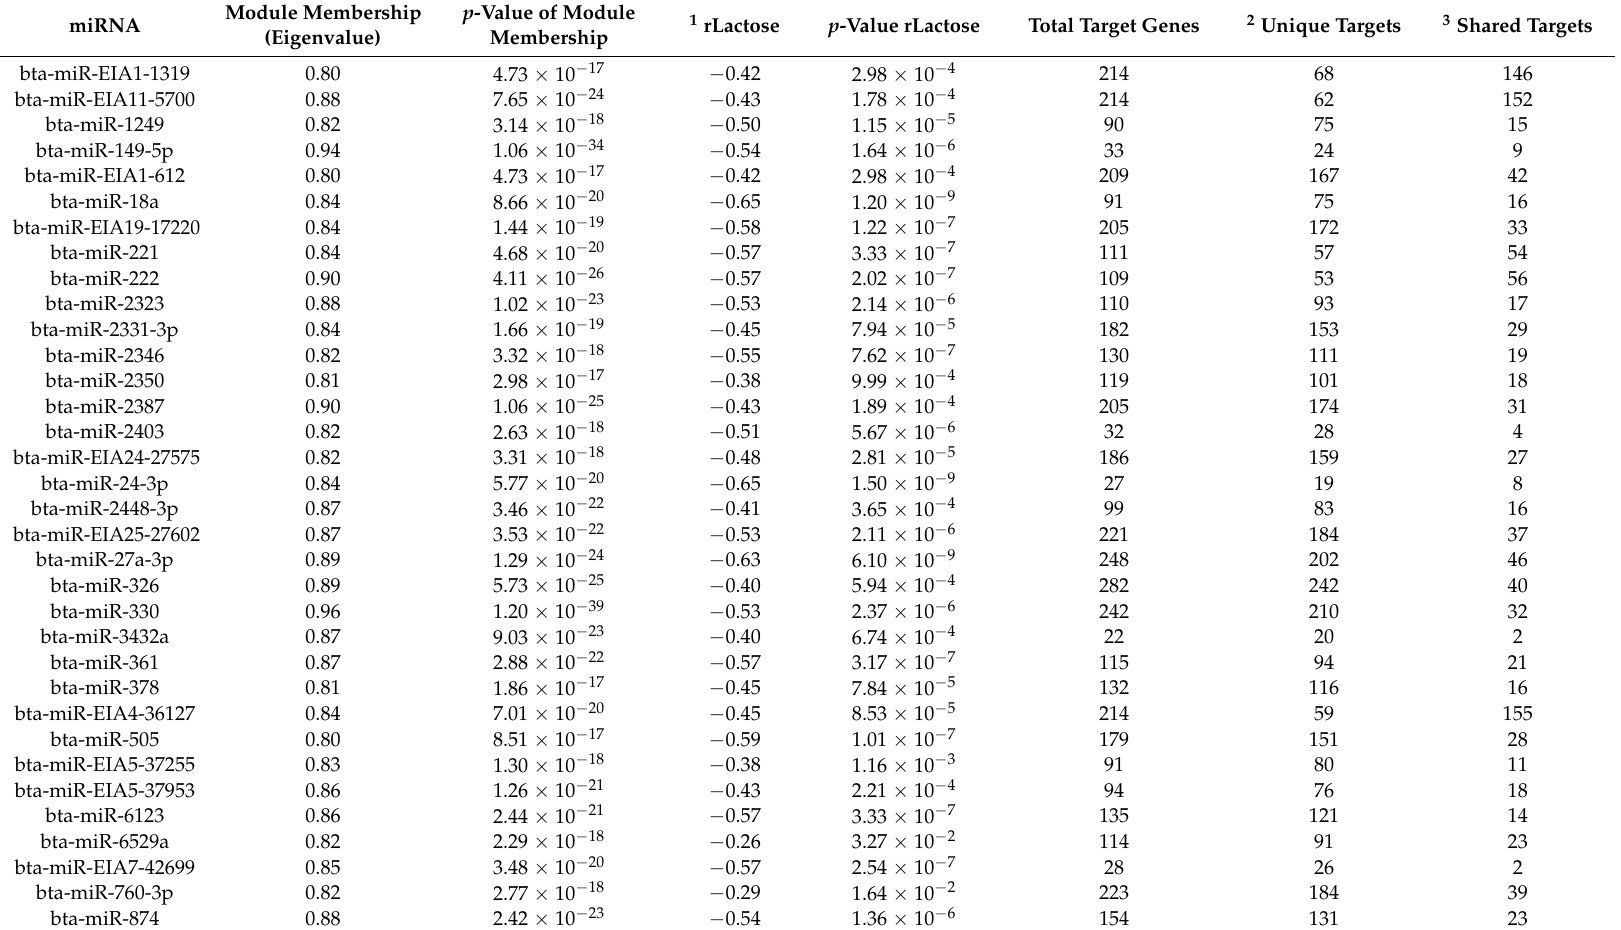
Table 3. miRNAs in the BLUE module, their correlation coefficients with lactose and predicted target